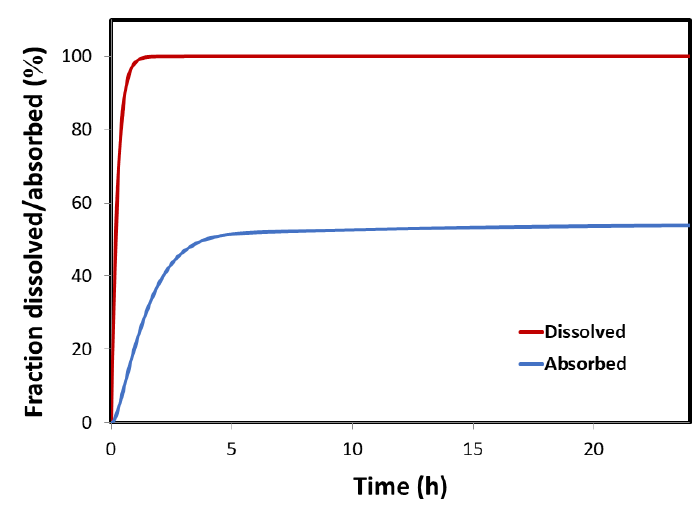
Figure 5. GastroPlus ® simulated dissolution and absorption profiles following p.o. administration of 40 mg furosemide dose (dissolution profile was simulated using the software default Johnson equation).